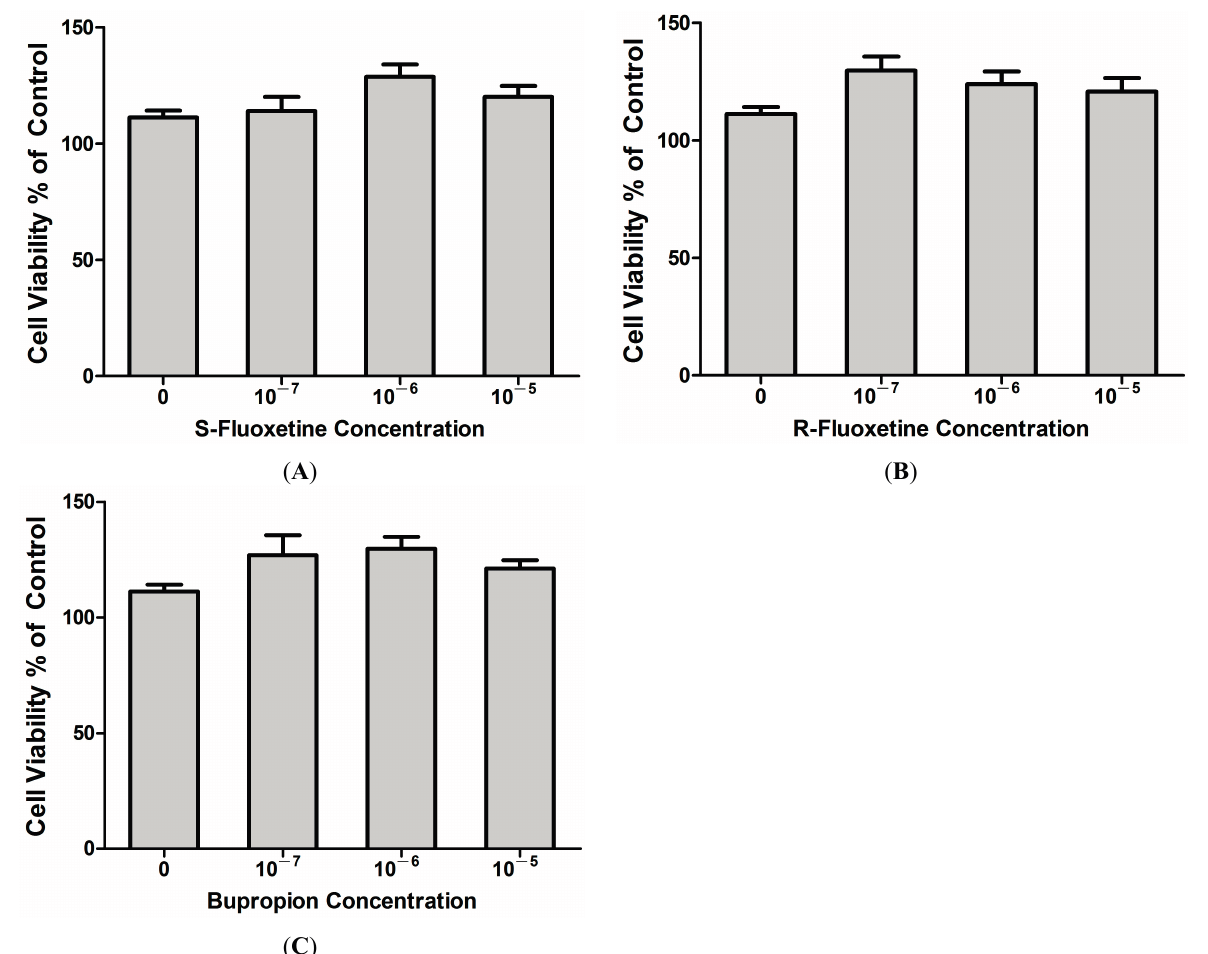
Figure 4. S-fluoxetine (0–10 − 5 M) ( A ); R-fluoxetine (0–10 − 5 M) ( B ) and bupropion (0–10 − 5 M) ( C ) had no cytotoxic effects in THP-1 cells led to suppressive effects of IP-10 expression after LPS (0.2 µg/mL)